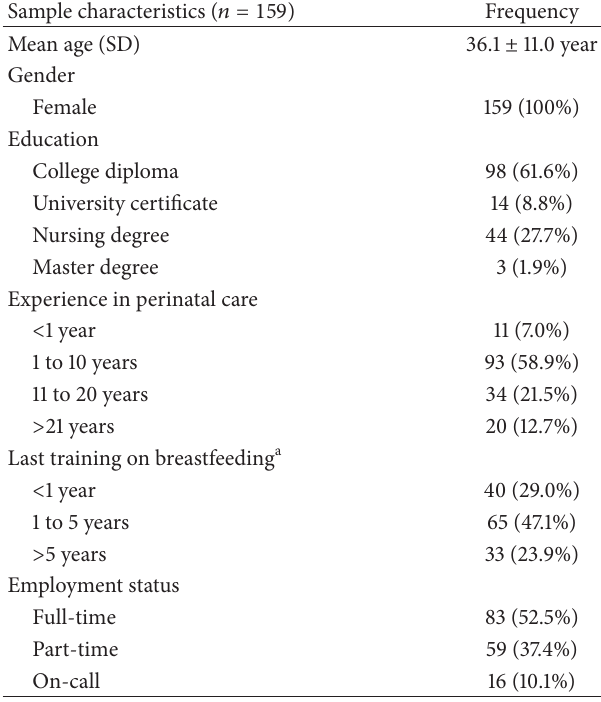
Table 2: Sociodemographic characteristics of the